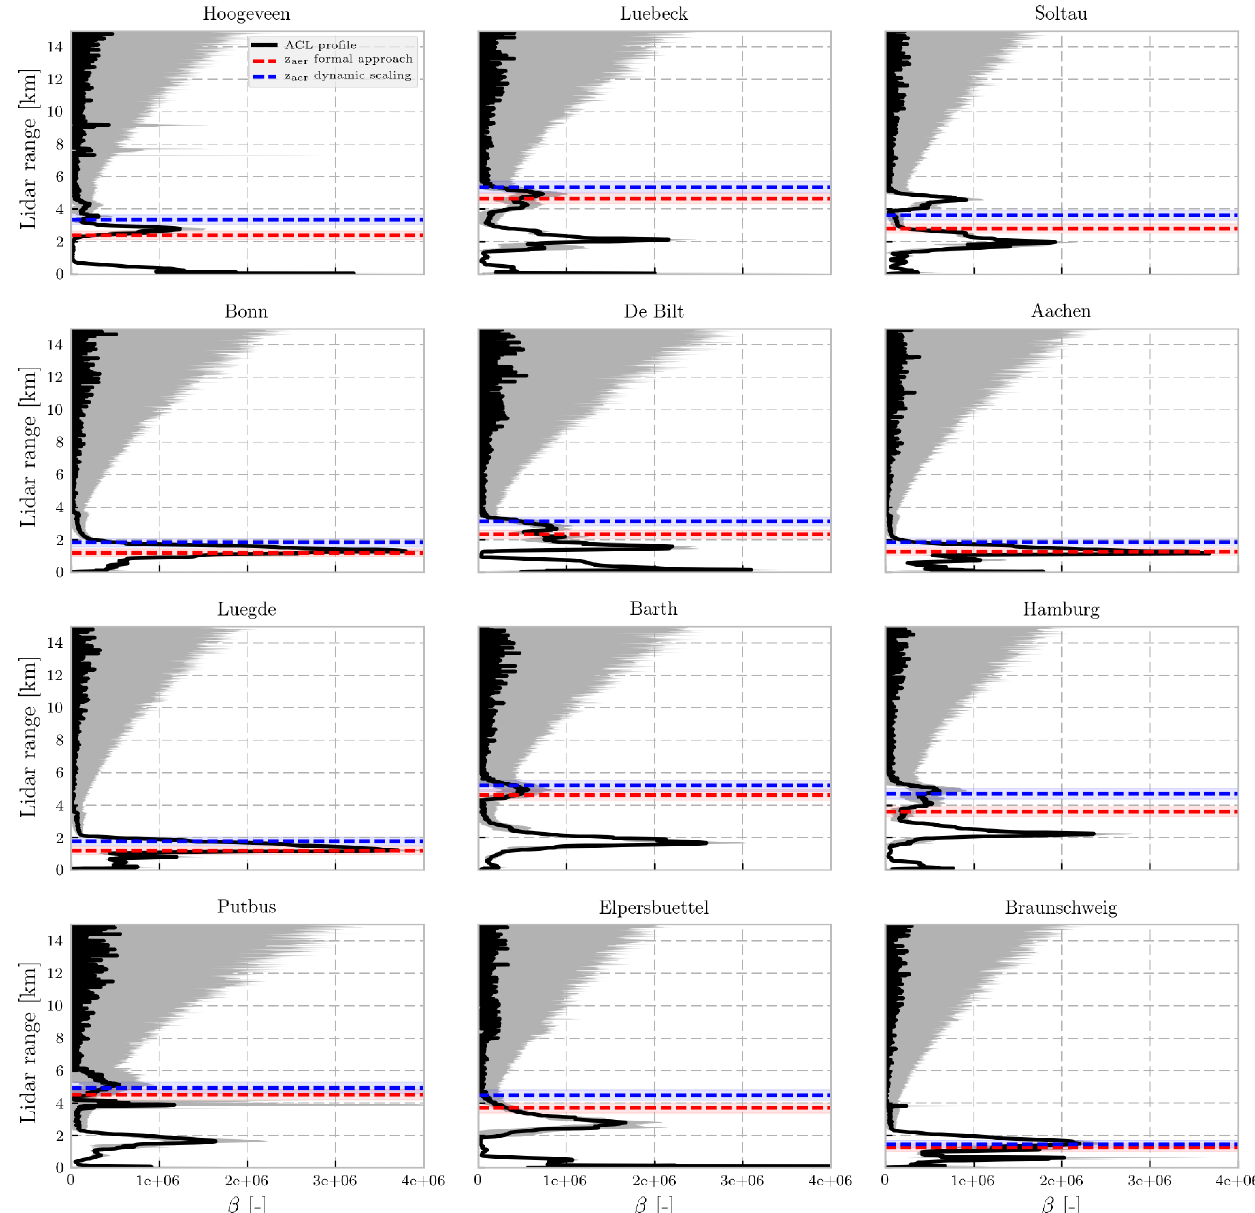
Figure 9. Validation of the retrieved aerosol layer height over western Europe from ceilometers located in the Netherlands and Germany from the CEILONET and DWD networks. The black lines represent averaged ceilometer profiles of acquisitions 1h before and after the GOME-2B overpass over each location (600 profiles). The profiles are uncalibrated raw attenuated backscatter β as a function of lidar range (km). The grey-shaded region represents the SD of the profiles used to create the averaged profile. The red and blue dashed line represents retrieved aerosol layer height using the formal approach and the dynamic scaling method, respectively. The red- and blue-shaded boxes represent the aerosol layer from the respective retrieval